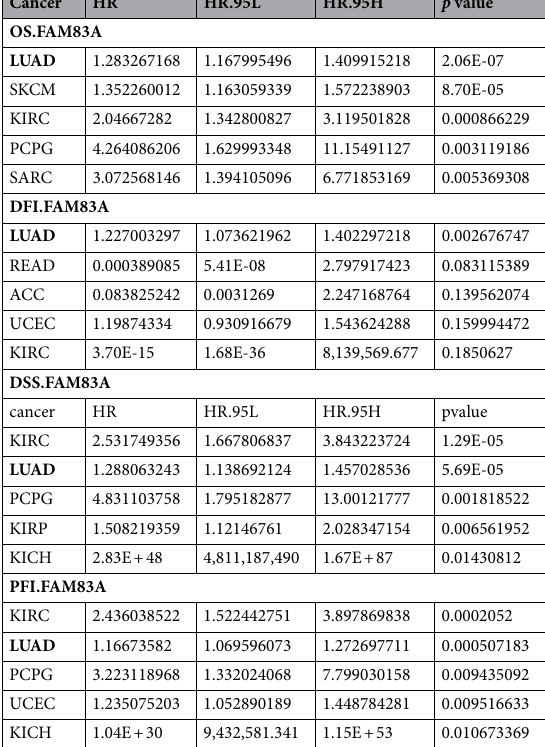
Table 2. Prognostic analysis of